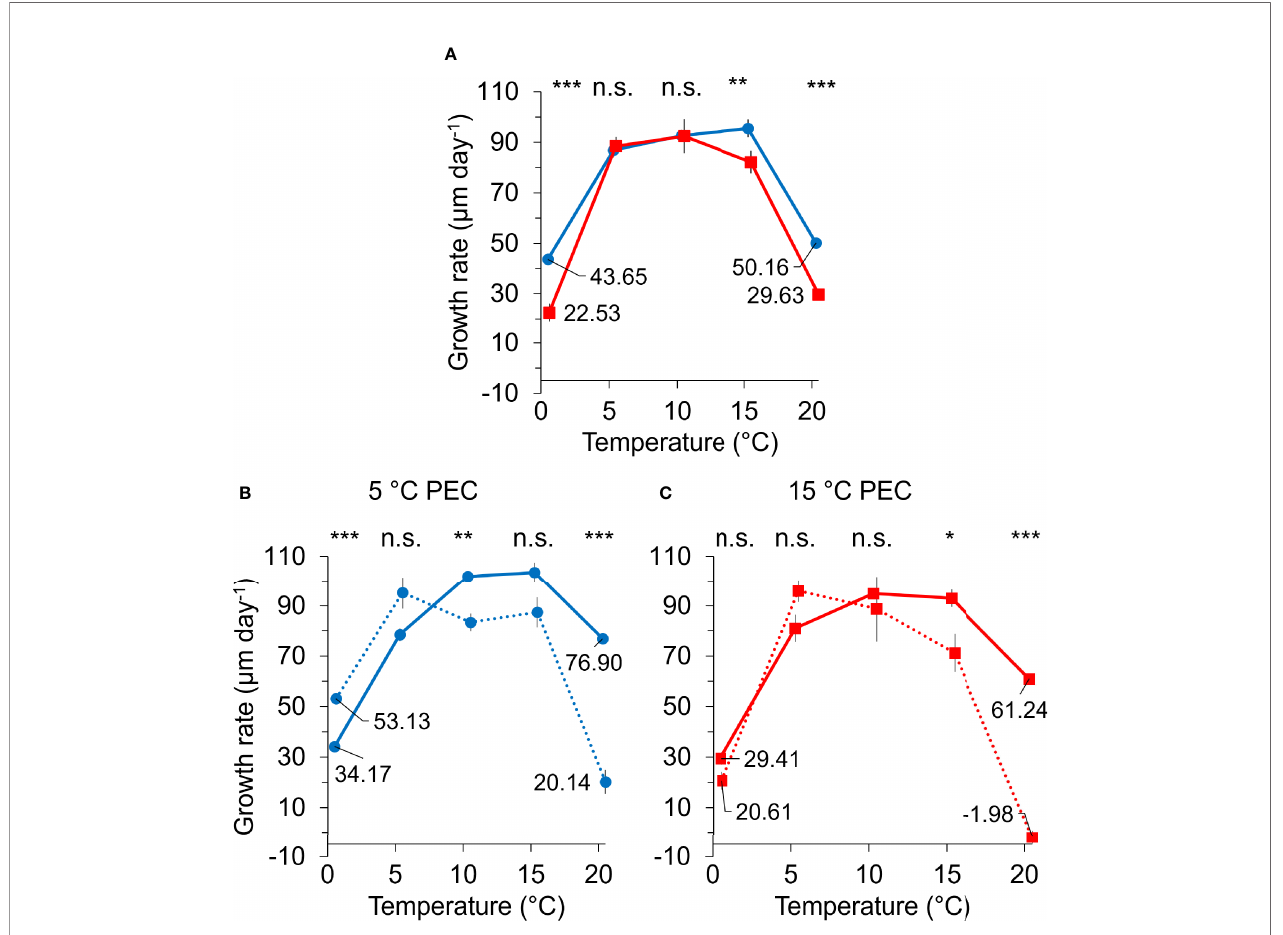
FIGURE 4 | Length growth rates of juvenile Laminaria digitata sporophytes in a temperature gradient (step 2) following pre-experimental cultivation (PEC) of parental gametophytes at 5°C (blue) and 15°C (red; mean ± standard error, n = 5). (A) Growth rates over 2 weeks following 5 and 15°C PEC. Asterisks represent signi fi cant differences between PECs (*** p < 0.001, ** p < 0.01, n.s. not signi fi cant; Tukey test). (B, C) Growth rates following (B) 5°C and (C) 15°C PEC between day 0 and 7 (full line) and day 7 and 14 (dotted line). Asterisks represent signi fi cant differences between day 0 and 7 and day 7 and 14 within an experimental temperature (*** p < 0.001, ** p < 0.01, * p < 0.05, n.s. not signi fi cant; paired